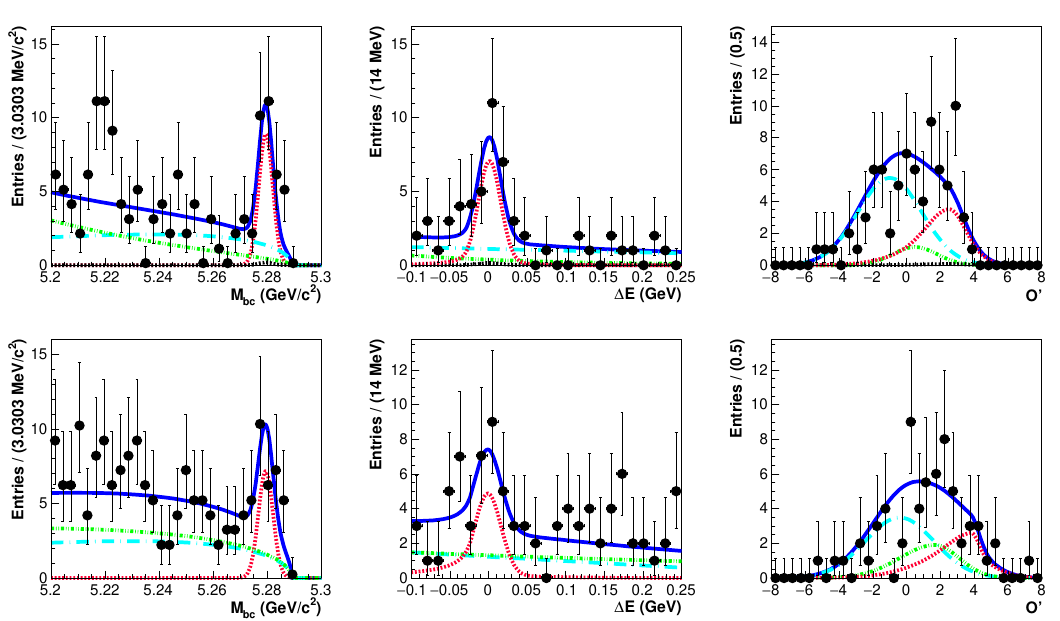
Figure 2 . Signal-enhanced M (left), ∆ E (middle), and O 0 (right) projections of three-dimensional bc unbinned extended maximum-likelihood fits to the data events that pass the selection criteria for B 0 → K 0 µ + µ − (top), and B 0 → K 0 e + e − (bottom). The legends are the same as in figure S S